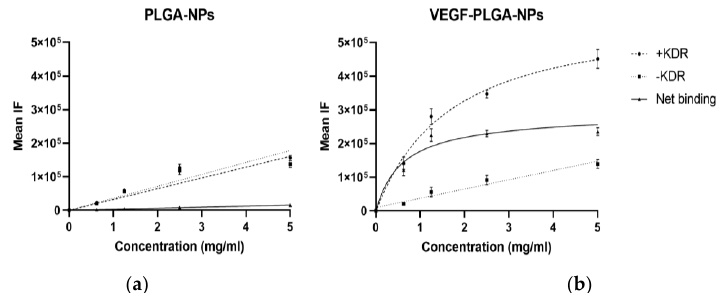
Figure 3. In vitro binding assay of PLGA-NPs ( a ) and VEGF-PLGA-NPs ( b ) to VEGF Receptor-2 (KDR) / Fc chimera human (KDR-Fc). KDR-Fc at concentration of 0.002 µ g / µ L was coated on the surface of 96-well plates. Two-fold dilutions of PLGA-NPs and VEGF-PLGA-NPs were incubated overnight